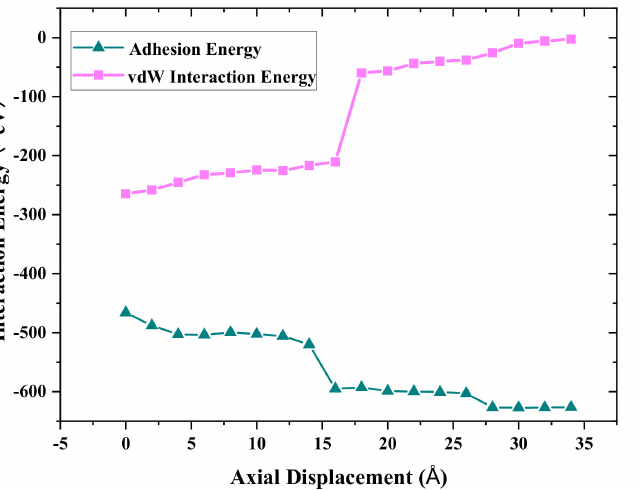
Figure 5. Variation of the adhesion energy and vdW interaction energy with the axial displacement.